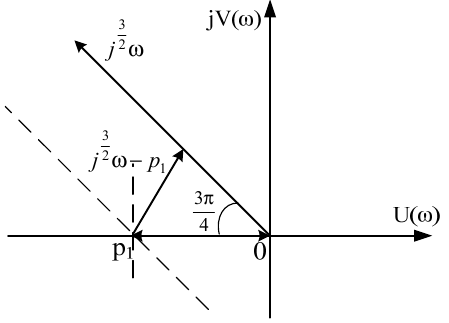
(cid:3119) (cid:16) (cid:17) (cid:3118) 𝜔 − 𝑝 (cid:2869) (cid:4673) for the first root providing 𝜔 𝜖 (0, ∞) .